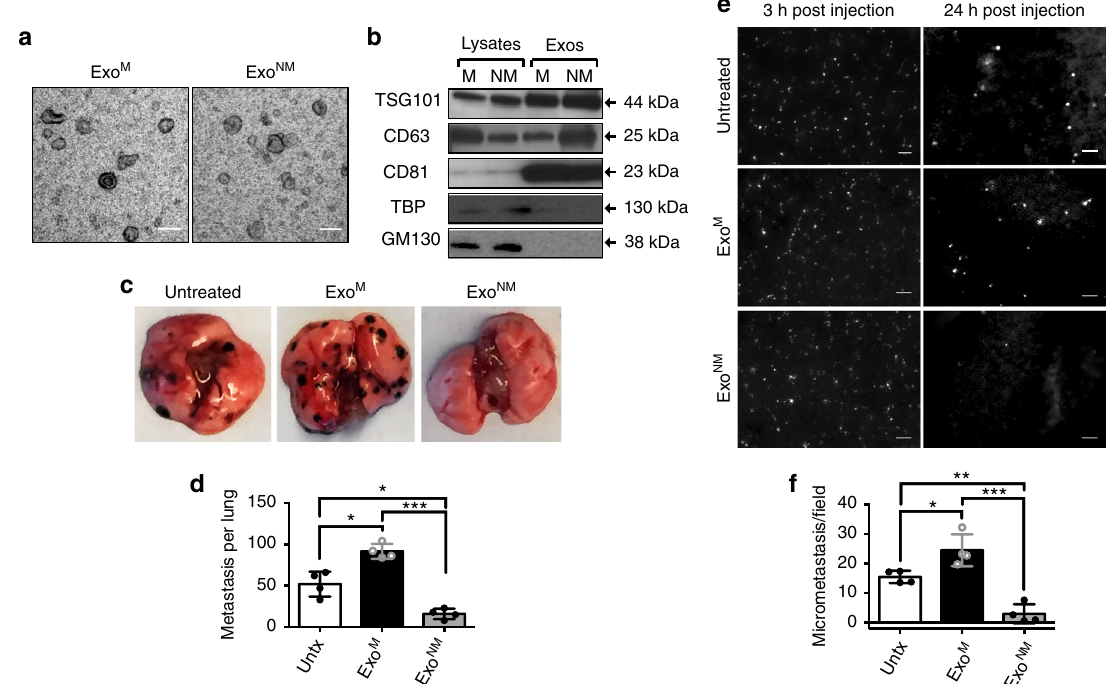
Fig. 1 Exo NM inhibit lung colonization by metastatic melanoma. a TEM of exosomes isolated by differential ultracentrifugation from metastatic and non- metastatic subcultures of mouse B16F10 melanoma cells. Note similar size and morphology of the Exo M and Exo NM preparations. Scale bar, 50 nm. b Western blot of cell lysates and exosomes (Exo) from metastatic (M) and non-metastatic (NM) melanoma cells, probed for ESCRT protein TSG101 and tetraspanins CD63 and CD81, to verify for enrichment in exosome preparation and GM130 and TBP (negative markers). c Lung colonization assay: C57BL/ 6 mice pre-conditioned with Exo M or Exo NM or untreated controls were inoculated intravenously with B16F10 melanoma cells ( n = 4). Gross images of the tumor burden 2-week post inoculation are shown. d Quanti fi cation of the lung colonies in c . * P < 0.05 and *** P < 0.001 by pairwise two-tailed Student ’ s t - test ( n = 4.). Mean and s.d. values are shown. e C57BL/6 mice preconditioned with Exo M , Exo NM , or untreated controls were inoculated with fl uorophore- tagged B16F10 cells. Fluorescence images of the lungs were taken 3 and 24 h after inoculation to assess perfusion and extravasation, respectively. Scale bar, 100 μ m. f Quanti fi cation of extravasated fl uorescent B16F10 cells in e . * P < 0.05, ** P < 0.01, and *** P < 0.001 calculated by pairwise two-tailed t -test; n = 4 mice per group, with a minimum of fi ve random images per lung evaluated. Mean and s.d. values are